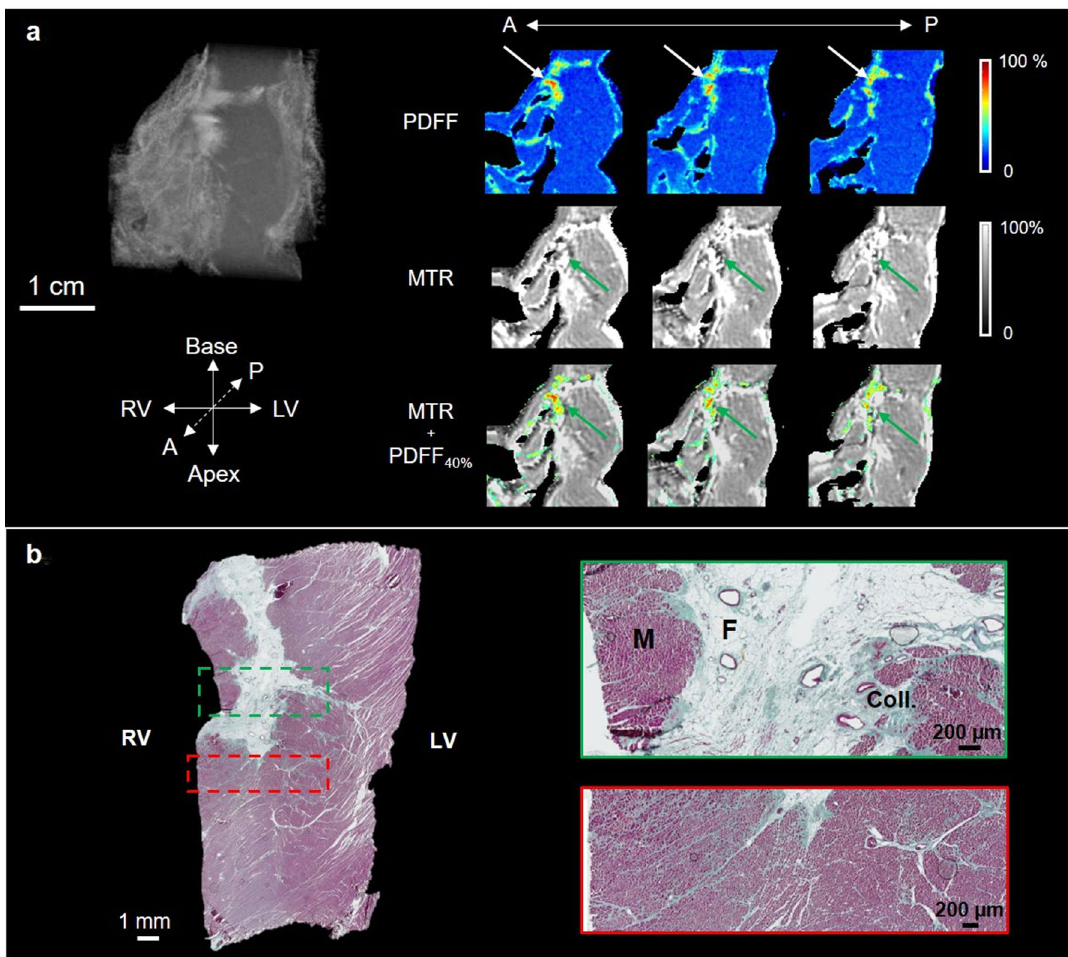
Figure 7. RV apex septum subsample of the ARVC heart. Coronal view of the septum sample (1.9 × 1.8 × 1.5 cm 3 ) in the apex region ( a ). PDFF with fat infiltration (white arrows), MT ratio (MTR) with fibrosis areas (green arrows) and MTR with fat > 40% (MTR + PDFF 40% ) overlaid are presented. All the MRI slices are 200 µm thick and separated by 1 mm. Corresponding histological slices ( b ) stained with Masson’s trichrome are also shown and zoomed regions (green and red dashed rectangles) are displayed. Muscle (M), fat (F) and collagen (Coll.) are